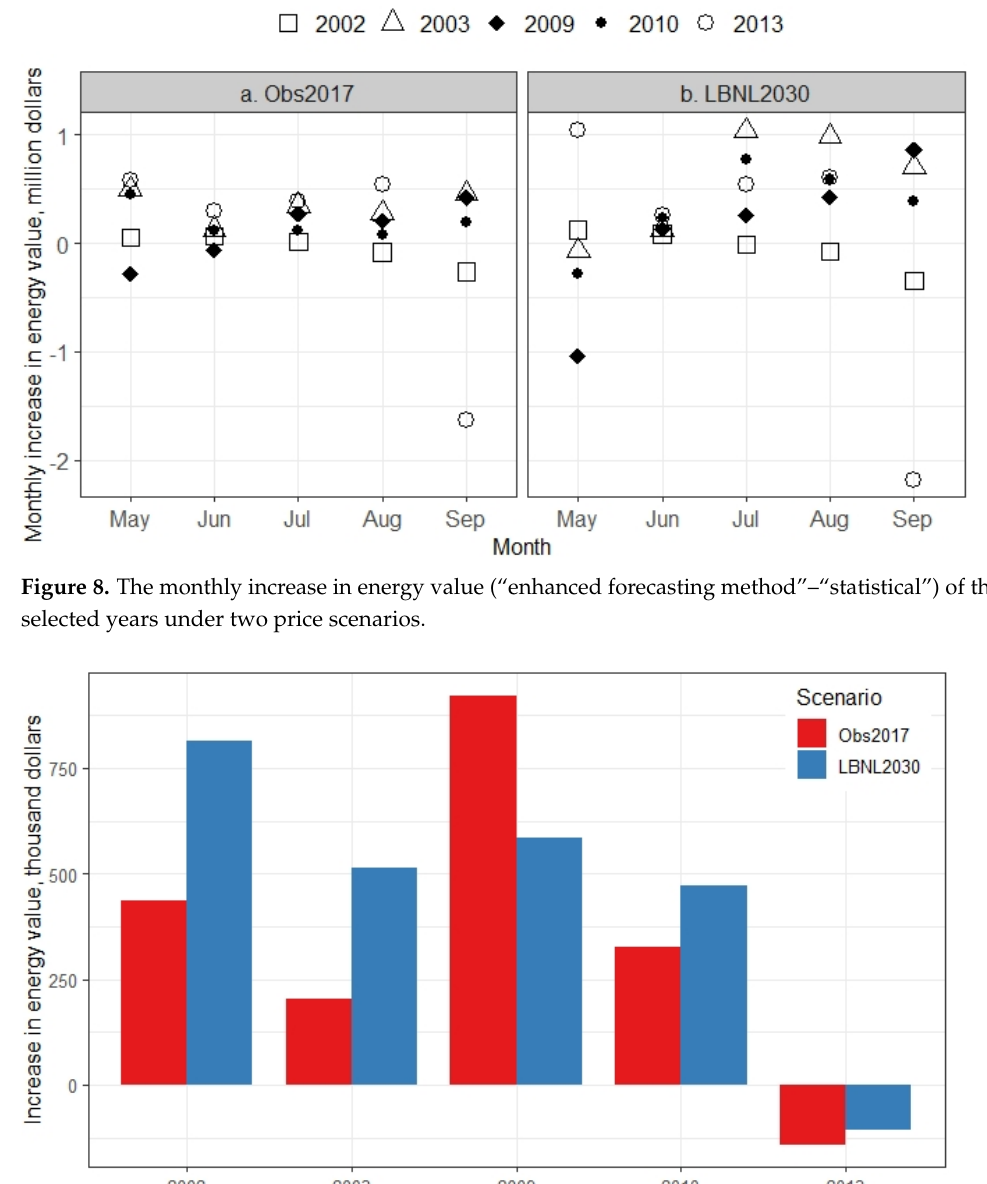
Table 4. Calculation of internal rate of return under the two prices scenarios.